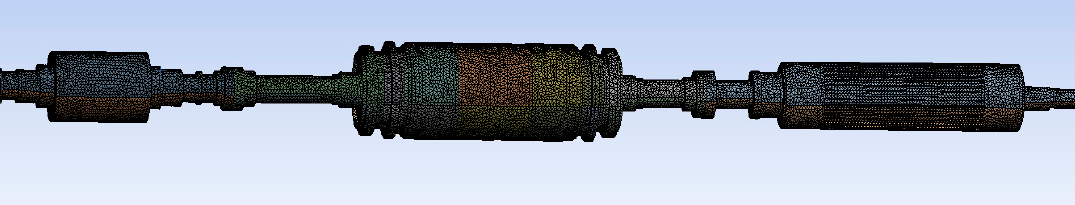
Figure 9. Meshed shaftline model.